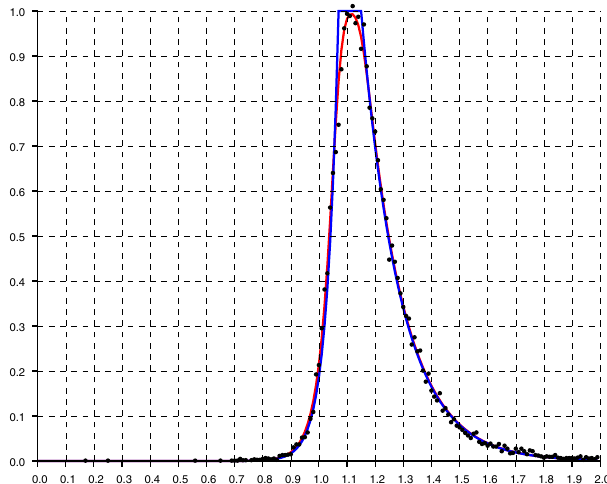
Figure 14. Histogram of the ratio of reported to actual distance based on about 20,000 measurements (scaled so that the peak equals one). The solid blue line is the “double exponential” with flat top parametric fit. The red curve is a smoothed version that takes into account measurement error with st. dev. of 0.25 m at 10 m.